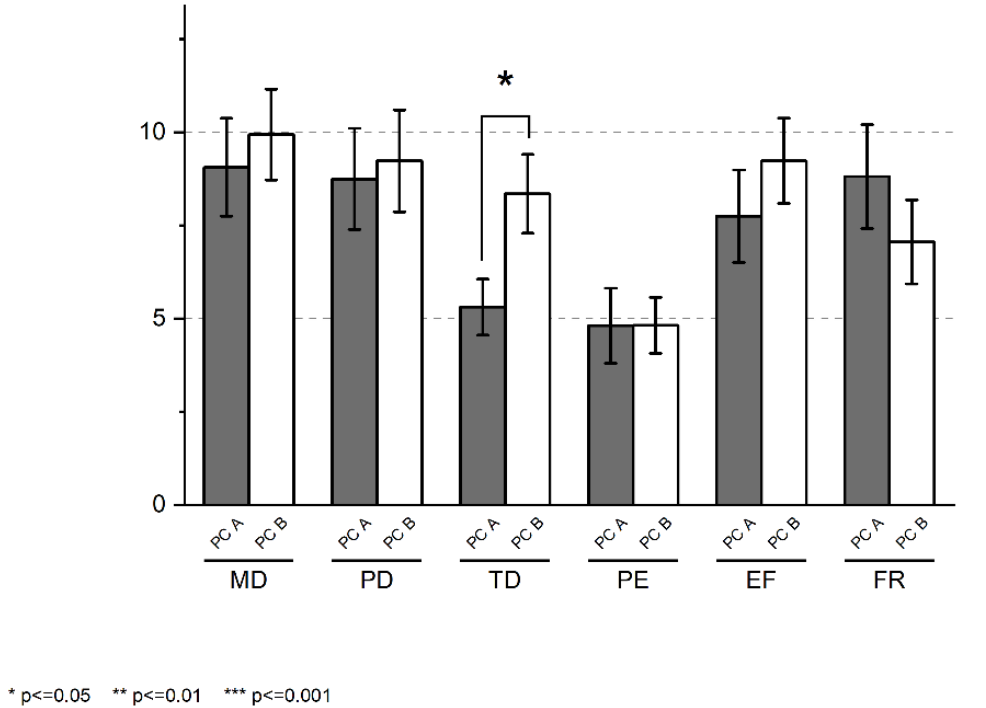
Figure 41. Sub-scale of NASA-TLX workload in PC assembly